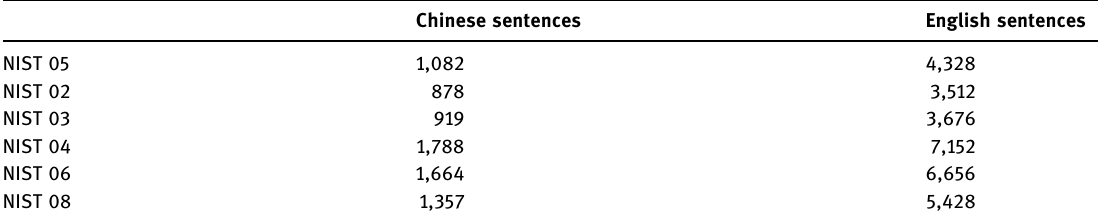
algorithm for the translation of complex English sentences 